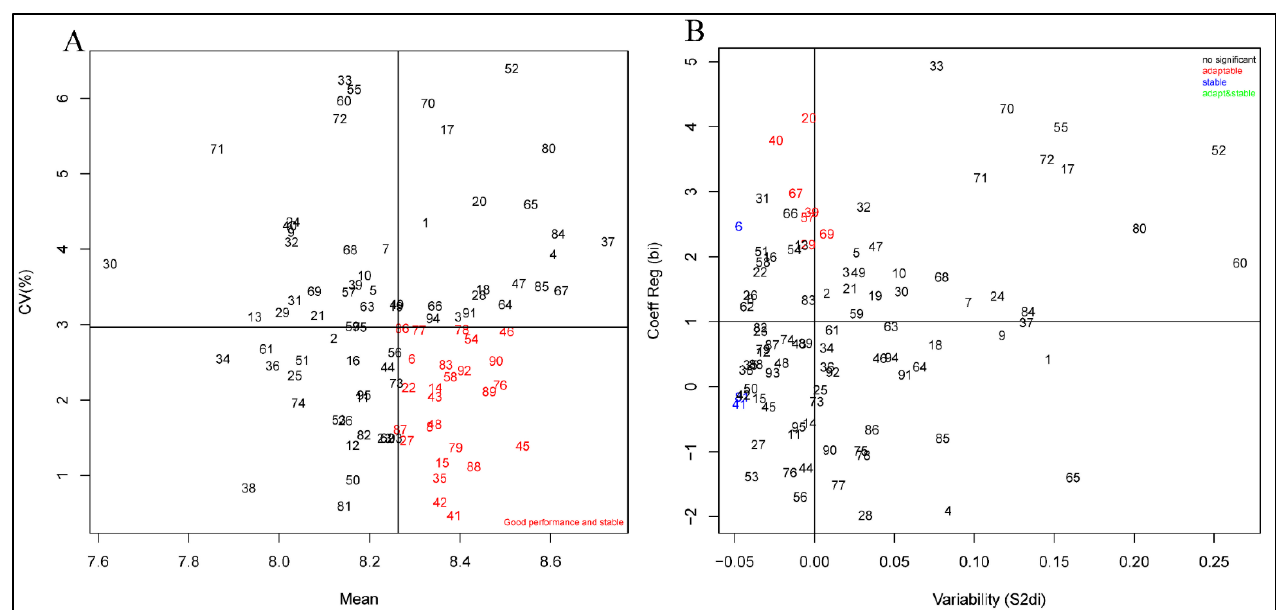
Figure 1. Stability analysis of the accessions with the environments. ( A ) Francis (CV) vs. mean biplot for grain yield. ( B ) Eberhart and Russell (bi, S2di) biplot for grain yield.